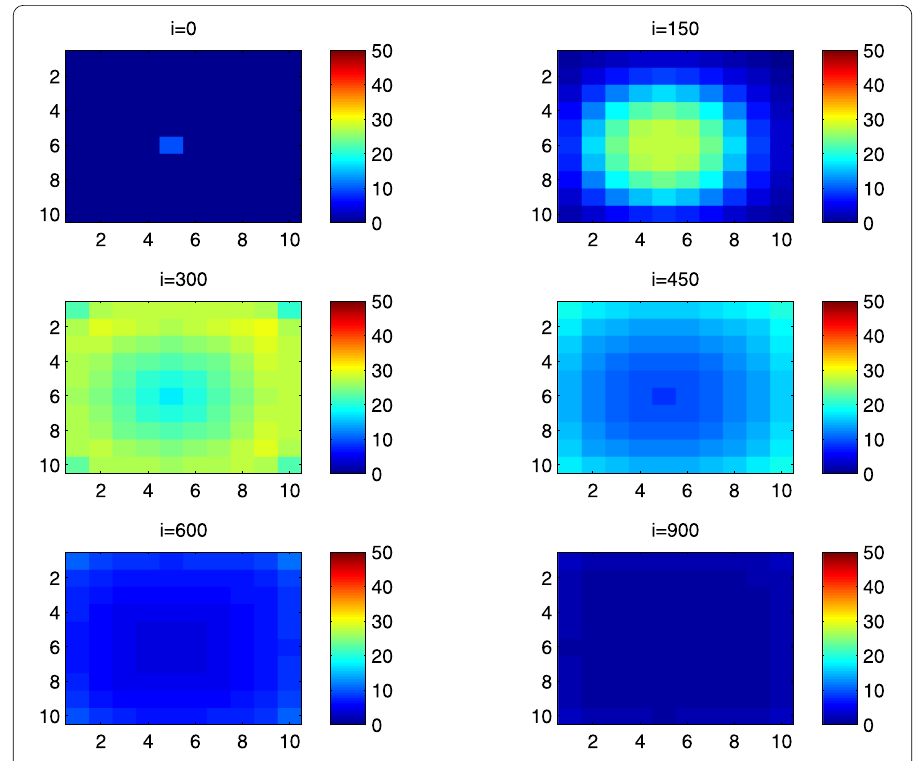
Figure 5 I Cpq behavior in the absence of control. The case when the disease starts from the center of (cid:2)